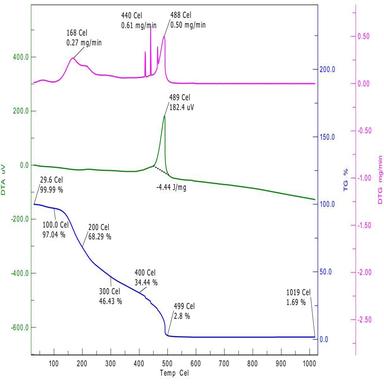
TGA, DTA and DTG curves of chit-cl-poly (AA-co-Am).